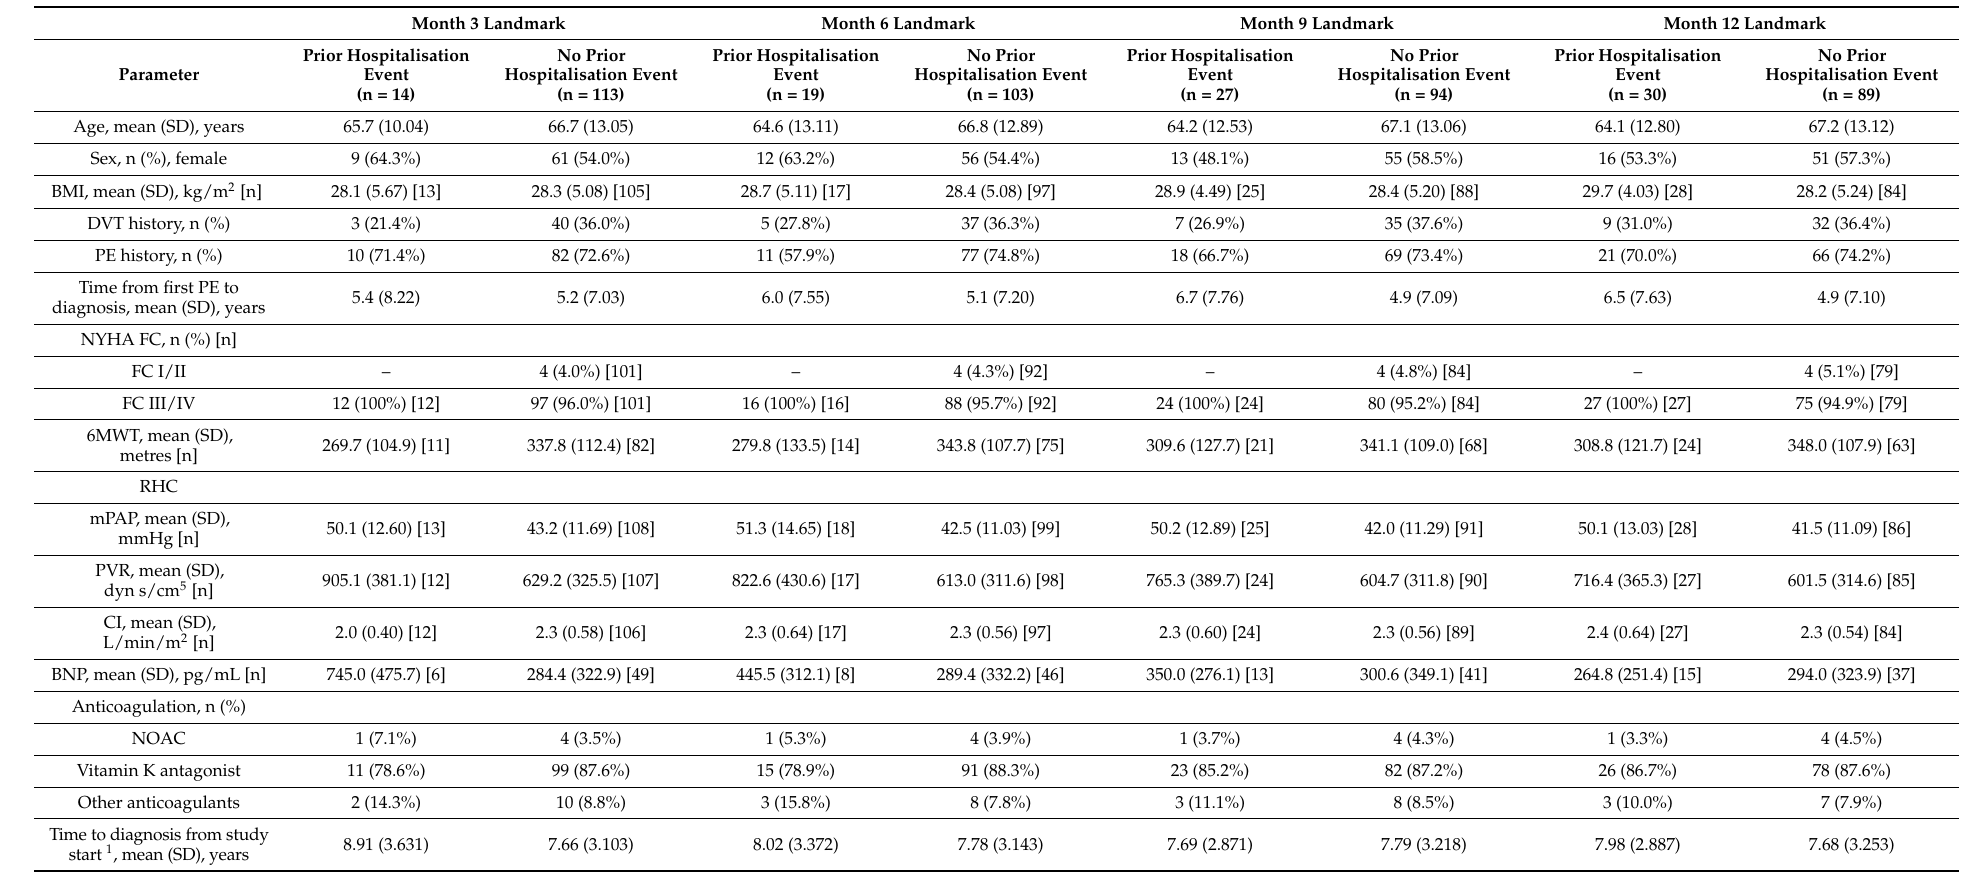
Table 1. Baseline characteristics of inoperable patients at landmark